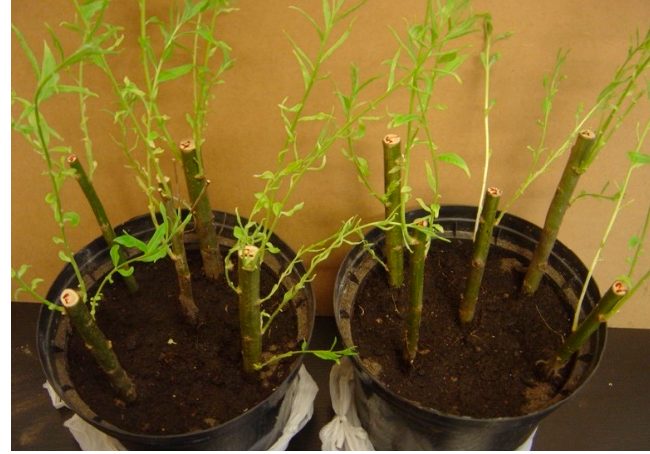
Figure 4. Spacing of energetic willow during the cultivation. Table 2. Growth of energetic willow shoots after four months of cultivation. Fertilized with Prednisonum Without Shoots